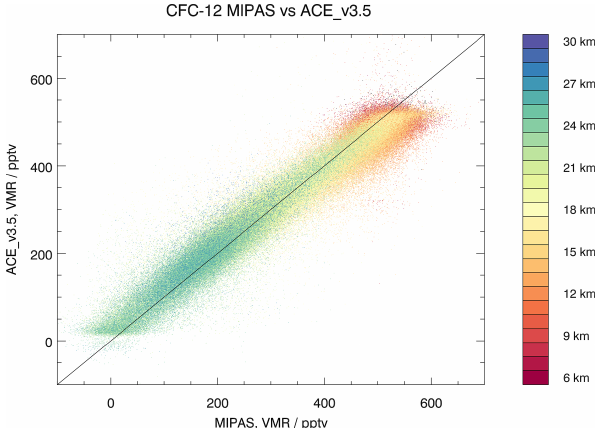
Figure 23. Correlation of collocated MIPAS CFC-12 measurements with ACE-FTS measurements during the time period of 2005 to 2012.